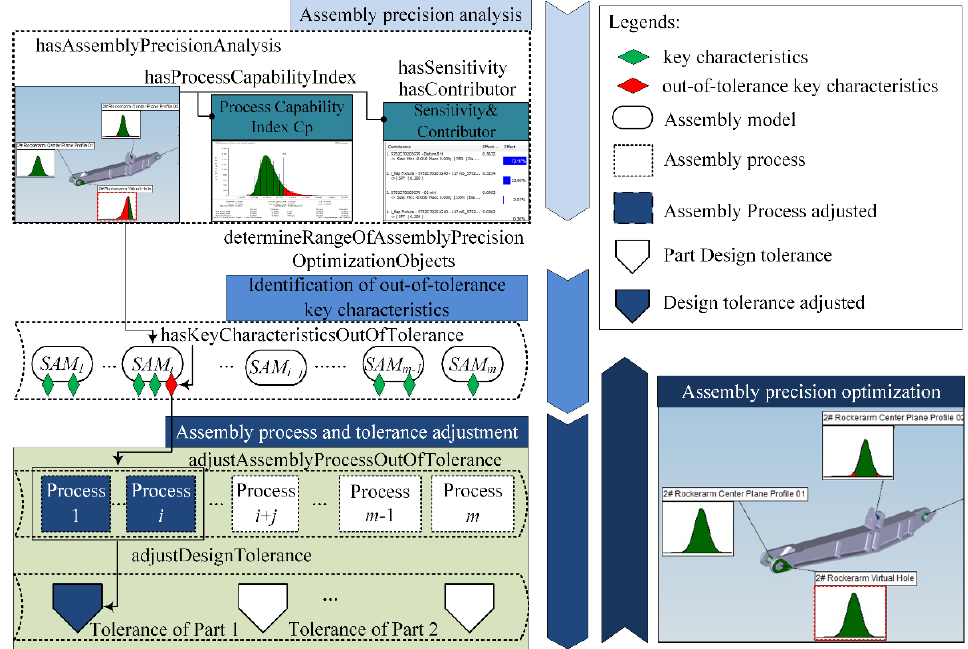
Figure 6. Assembly precision optimization semantic model.